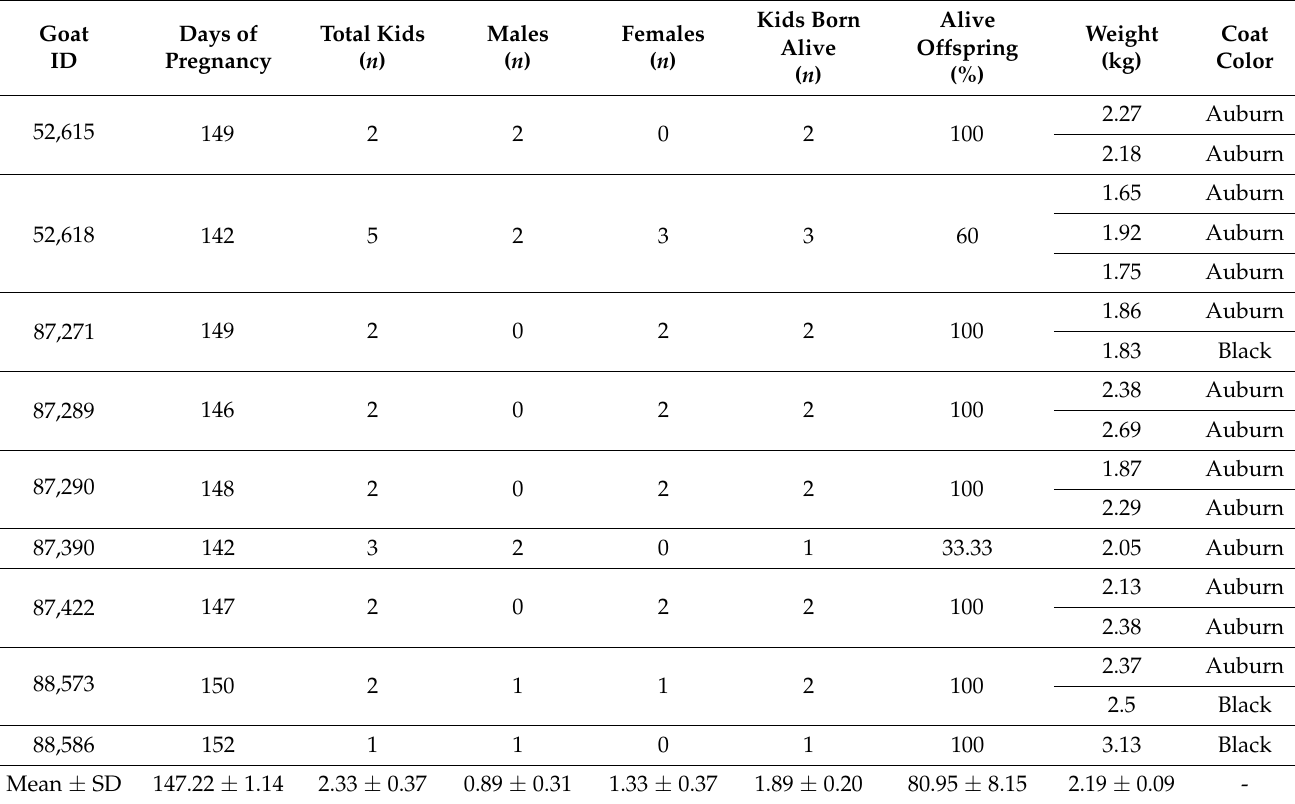
Table 3. Results of births in total goats under study ( n : 9). ID: Identification number of goat. Mean ± Standard Deviation